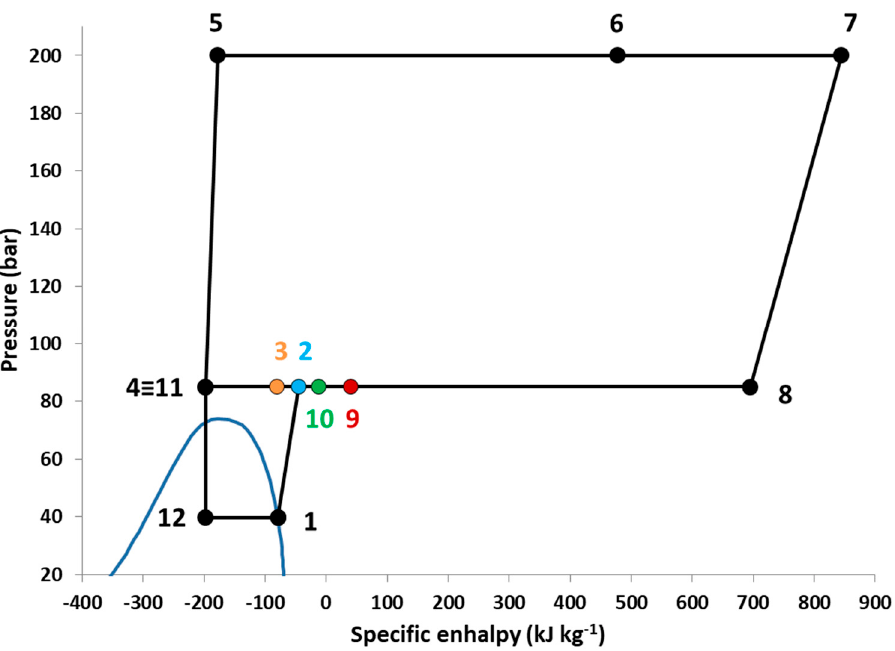
Figure 2. Pressure-specific enthalpy (p-h) diagram for the examined polygeneration system in nominal operating conditions.